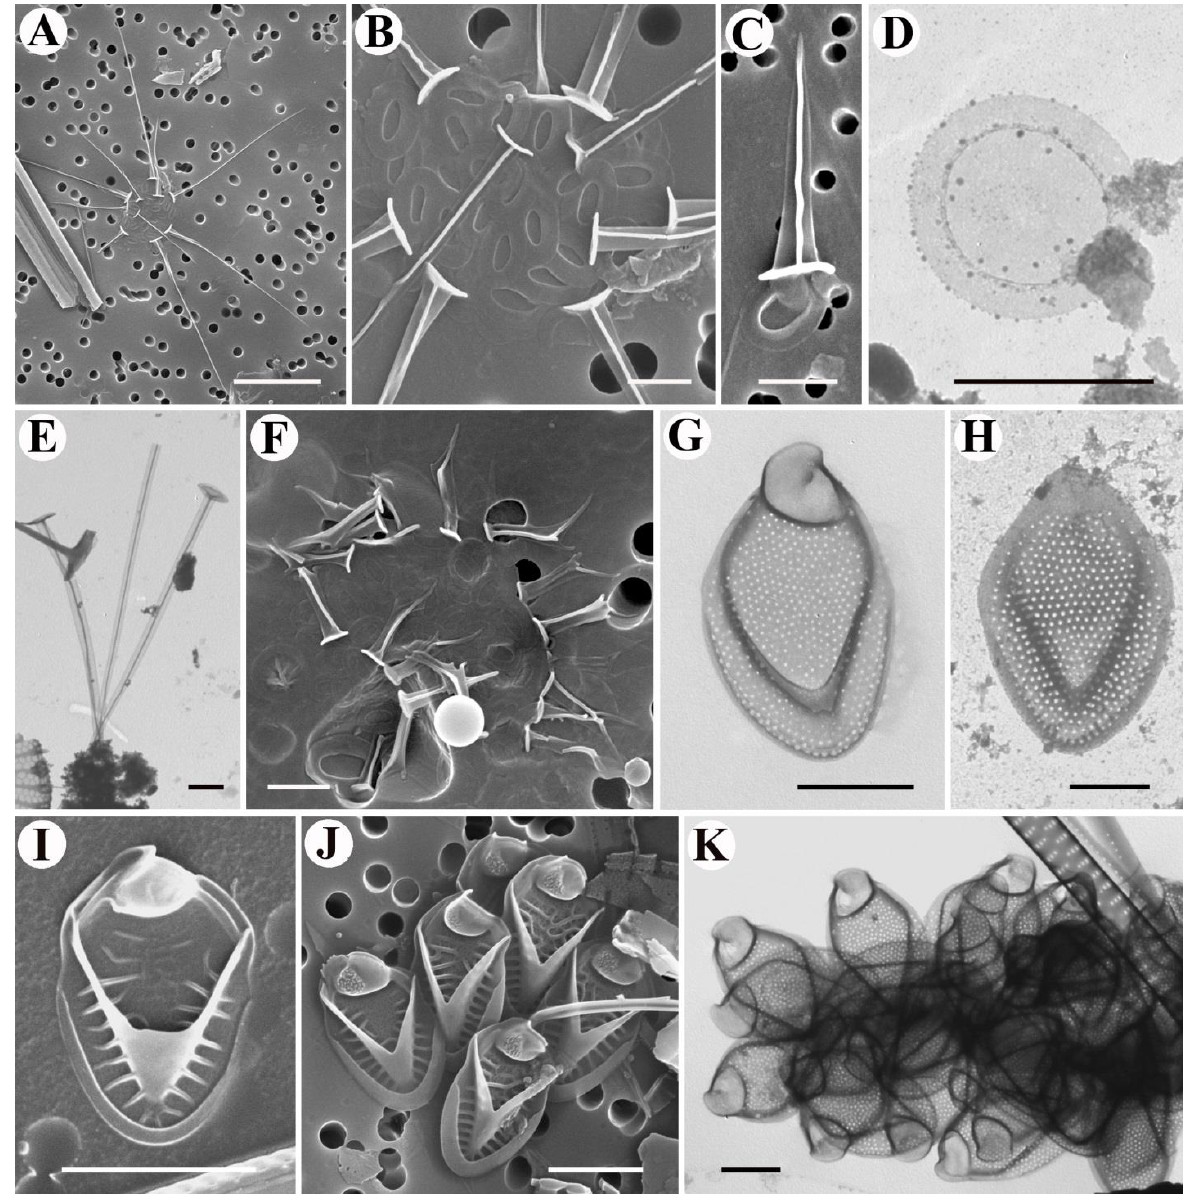
Fig. 3. SEM (A-C, F, I, J), TEM (D, E, G, H, K). Scales and spines of silica-scaled chrysophytes from Lake